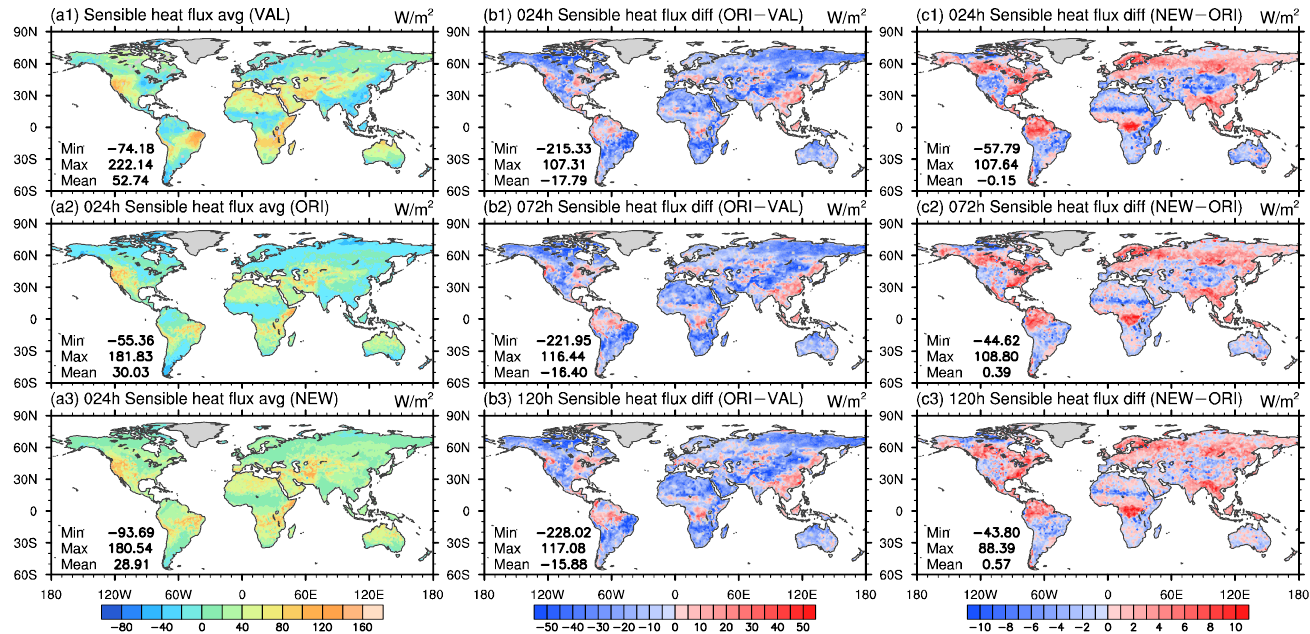
Figure 13. Same as Figure 9, but for daily sensible heat flux (units: W∙m − 2 ).